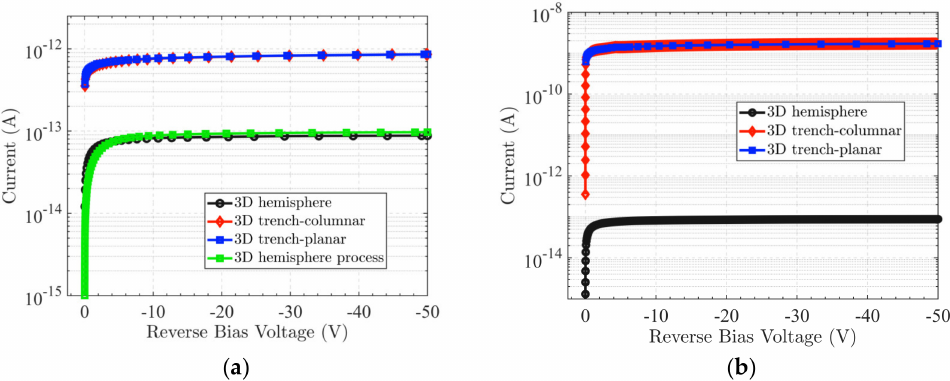
Figure 18. Leakage current comparison of different device structures; ( a ) Wafer thickness of 30 µ m; ( b ) Wafer thickness of 300 µ